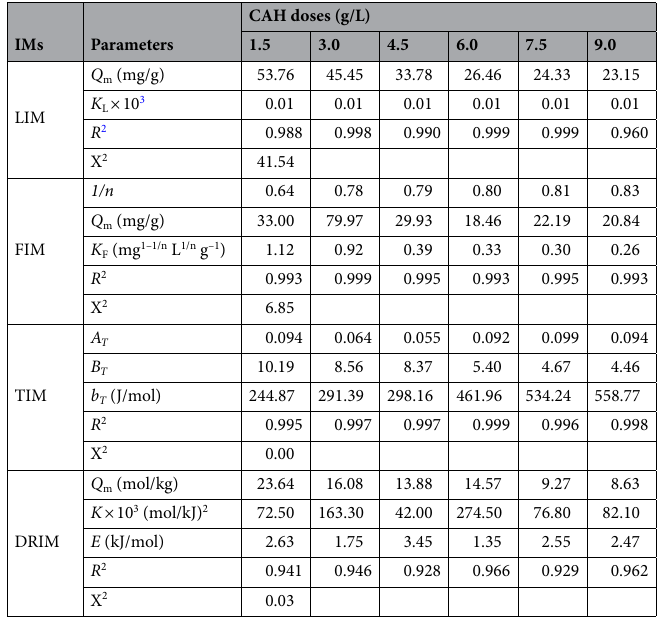
Table 2. IMs investigation results of DB86 dye absorption by CAH [ C 0 (25–200 mg/L), CAH doses (1.5– 9.0 g/L), and temp. (25 ± 2